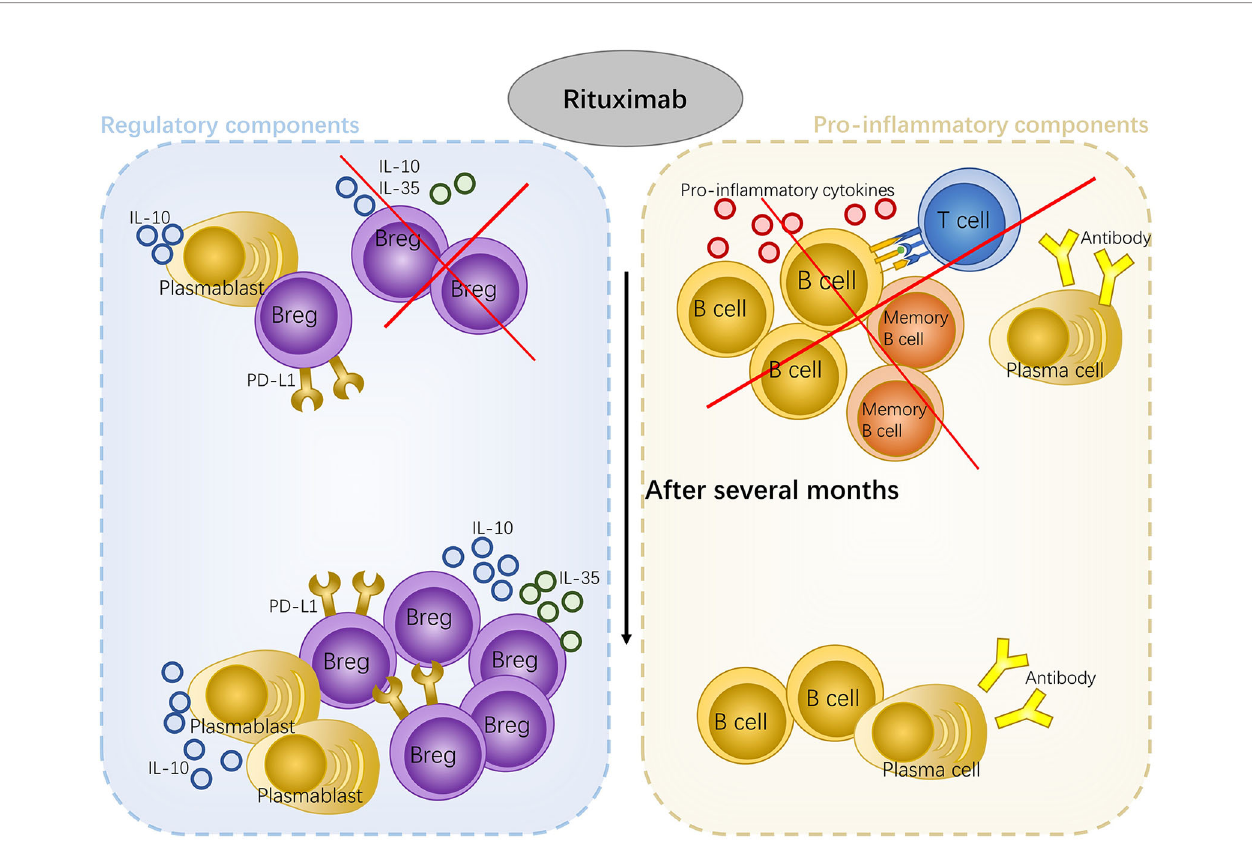
FIGURE 3 | The mechanism of rituximab treatment in uveitis. Rituximab eliminates effector B cells and malfunctioning Bregs as well as induces the restoration of the quantity and function of Bregs. Some regulatory B cell lines resistant to rituximab also expand and contribute to the ef fi cacy of this